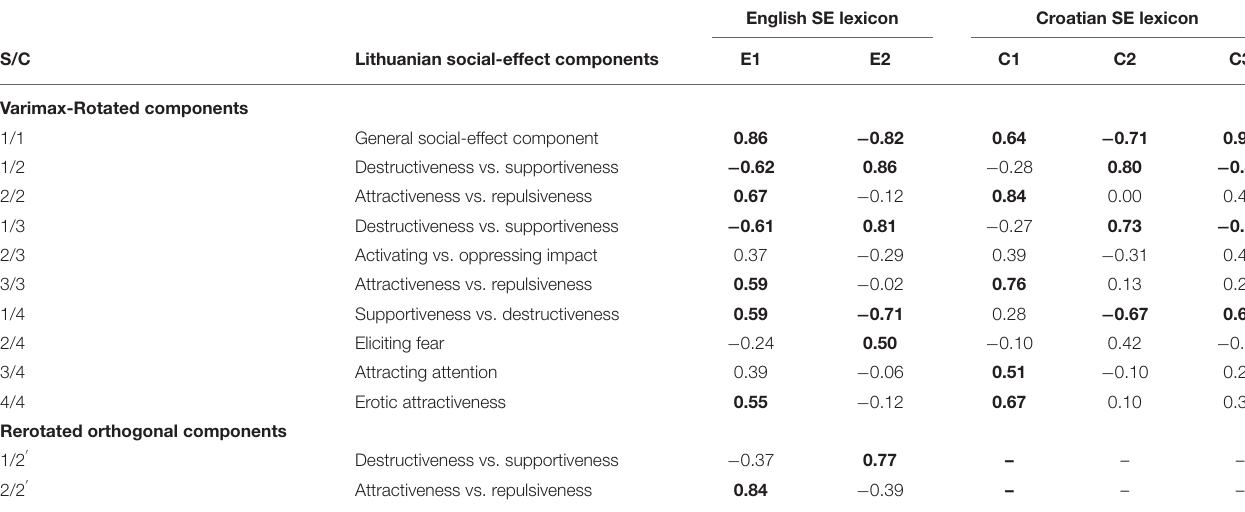
TABLE 5 | The relationship between Lithuanian, English, and Croatian social-effect lexicons in the observer-rating